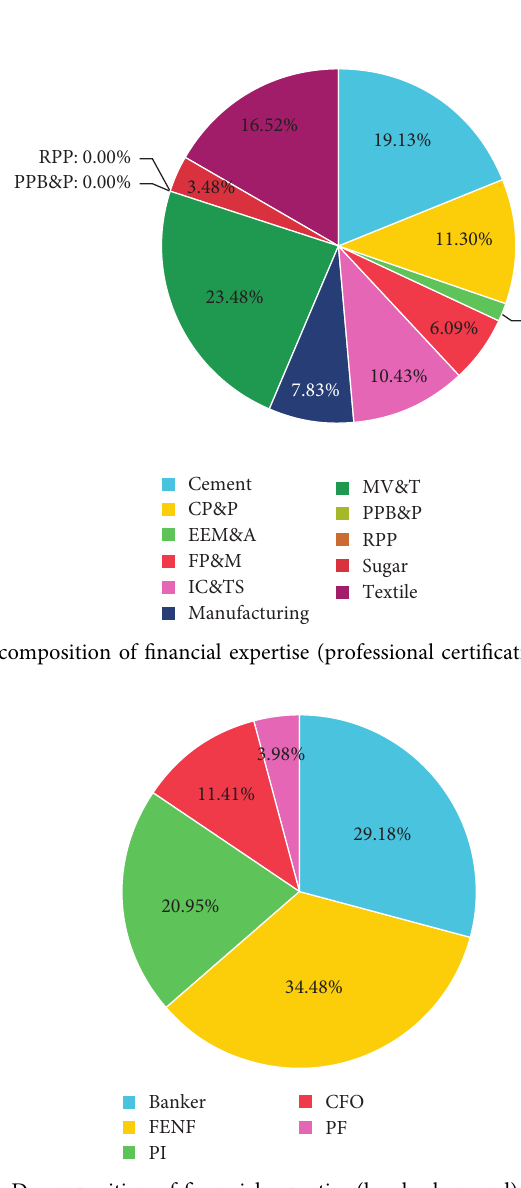
Figure 7: Decomposition of financial expertise (law background) in equity market.